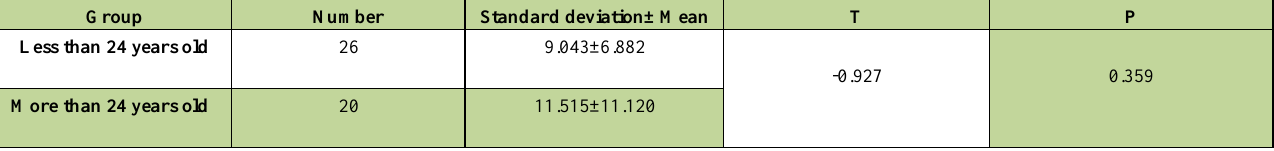
Table 3. Comparison of mean difference of first period index plaque between two age groups.